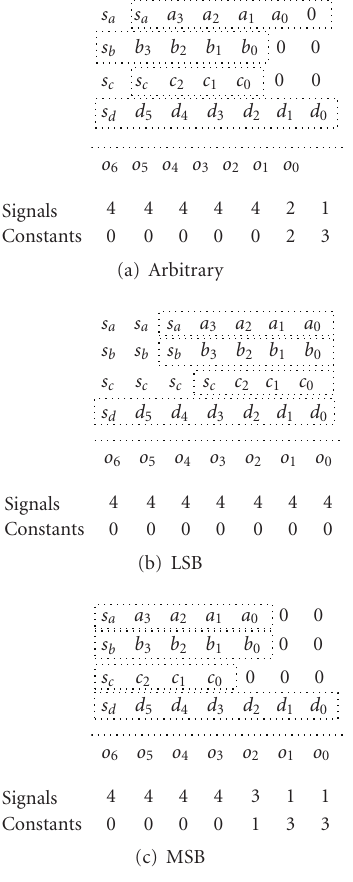
Figure 2: Signal alignment.